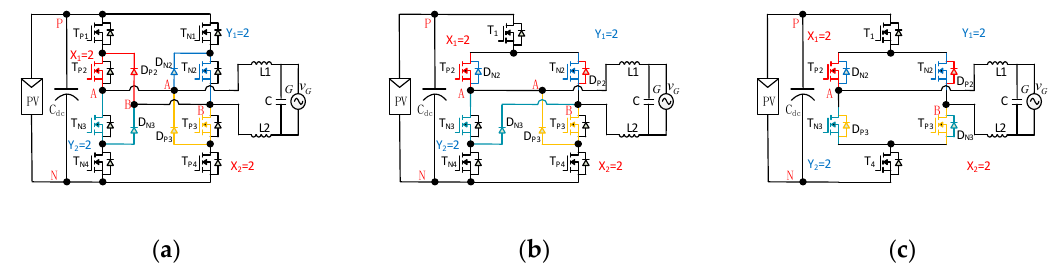
( i ) Figure 22. Six modes of M10 topology. ( a ) PC and NC modes; (b) PFT mode #1; ( c ) PFT mode #2; ( d ) PFB mode #1; ( e ) PFB mode #2; ( f ) NFT mode #1; ( g ) NFT mode #2; ( h ) NFB mode #1; ( i ) NFB mode #2. In PFT mode, switches T P1 , T P3 , T N1 , T N2 , T N3 , and T N4 are off, and switches T P2 and T P4 are on. One diode, D P2 , is added for the positive output current flow, as shown in Figure 22b. Diode D P2 is served by the body-diode of switch T N2 . The reflected PFT mode is shown in Figure 22c. In PFB mode, switches T P2 , T P4 , T N1 , T N2 , T N3 , and T N4 are off, and switches T P1 and T P3 are on. One diode, D P3 , is added for positive output current flow, as shown in Figure 22d. Diode D P3 is served by the body-diode of switch T N3 , as shown in Figure 22e. It is easy to make a similar analysis for NFT and NFB modes. Figure 22f,g show the two NFT modes, while the two NFB modes are shown in Figure 22h,i. It should be noted from the above analysis that there are two PFT modes, two PFB modes, two